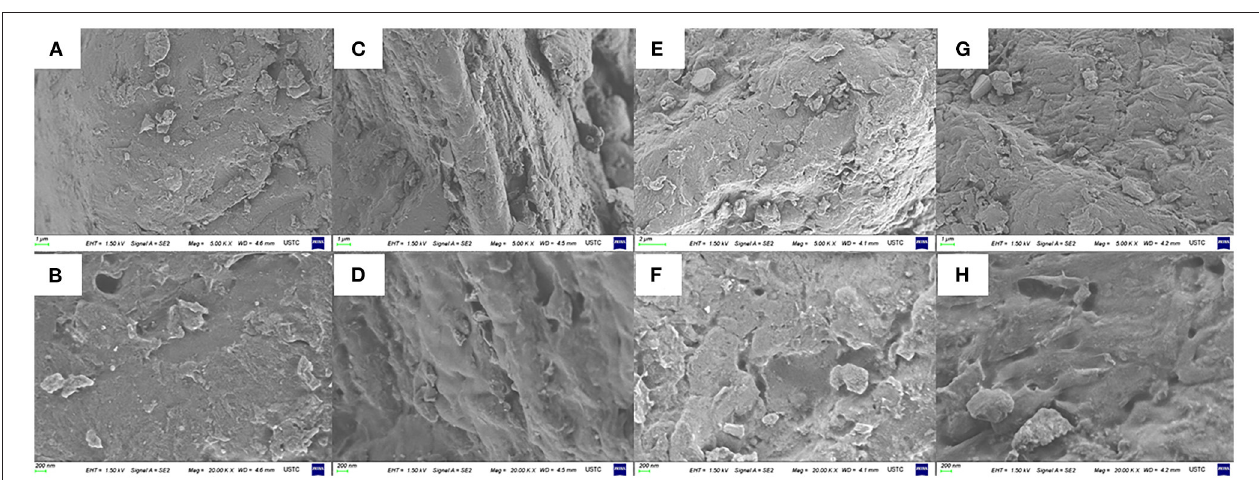
FIGURE 3 | The surface morphologies of RPA at 5.00K × and 20.00K × magnifications in the DP-0 (A,B) , DP-60 (C,D) , DP-120 (E,F) , and DP-180 (G,H) groups.